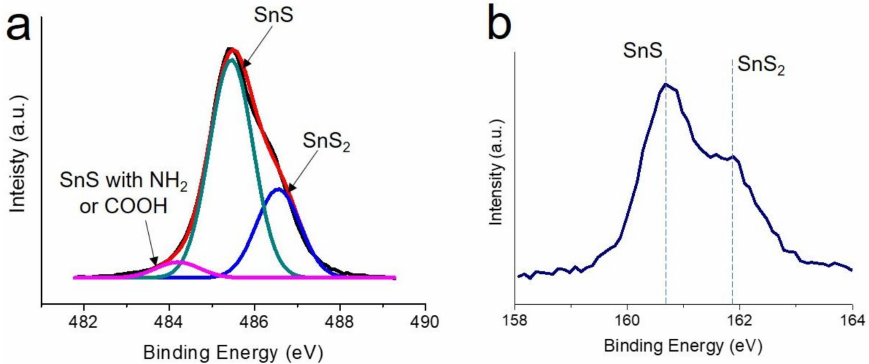
Figure 3. X-ray photoelectron ( a ) Sn 3d and ( b ) S 2p spectra for the F-SnS